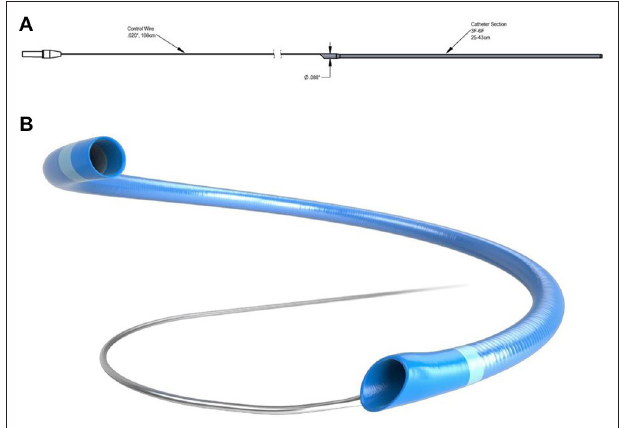
FIGURE 3 | (A,B) 6F R4Q aspiration catheter system from MIVI (Eden Prairie, MN, USA) where the proximal portion is replaced by a wire to increase aspiration flow